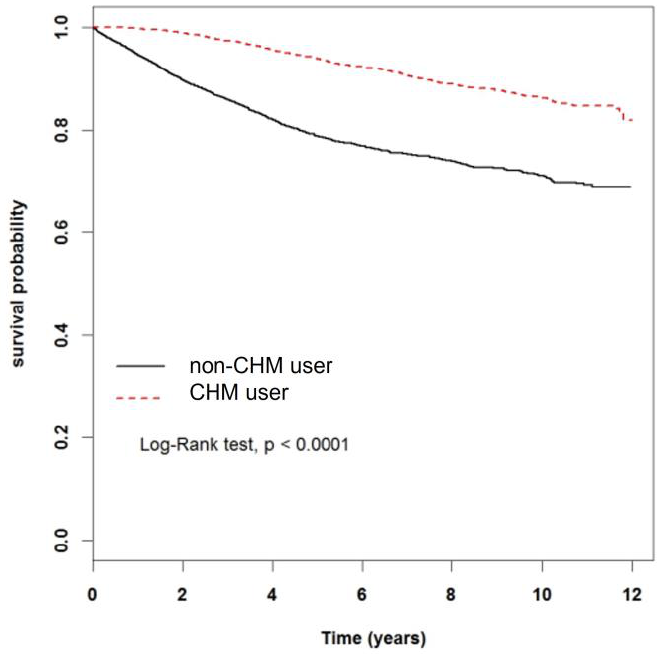
Figure 2. Kaplan–Meier curves for the survival analysis in breast cancer patients with and without taking CHM.